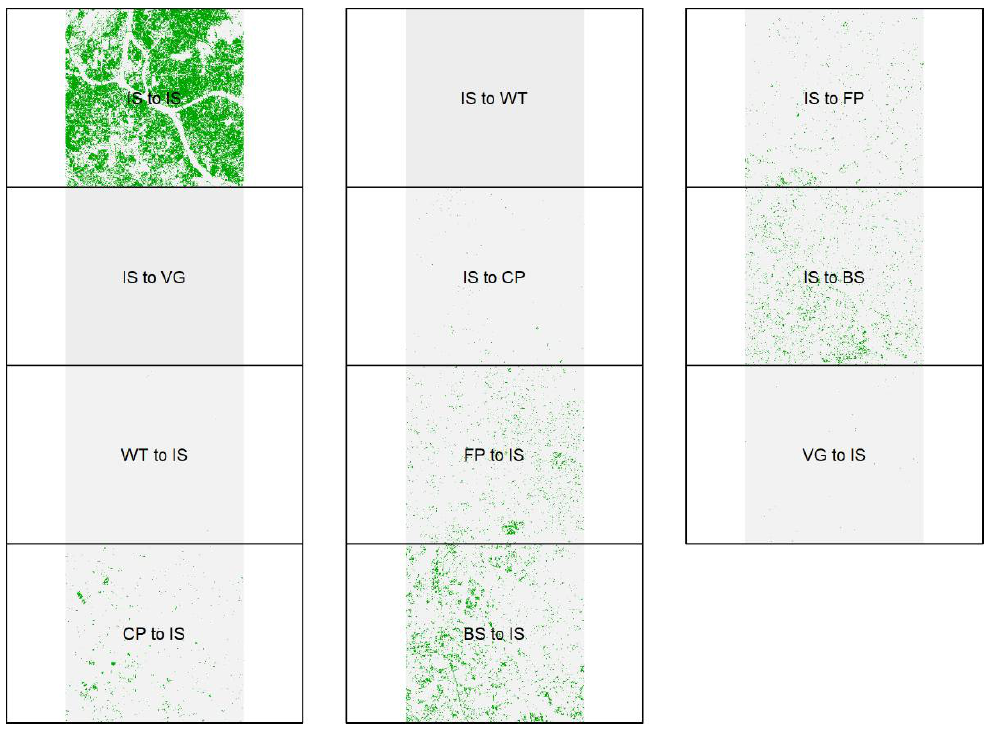
Figure 7. Impervious Surface related land changes in Region 1.